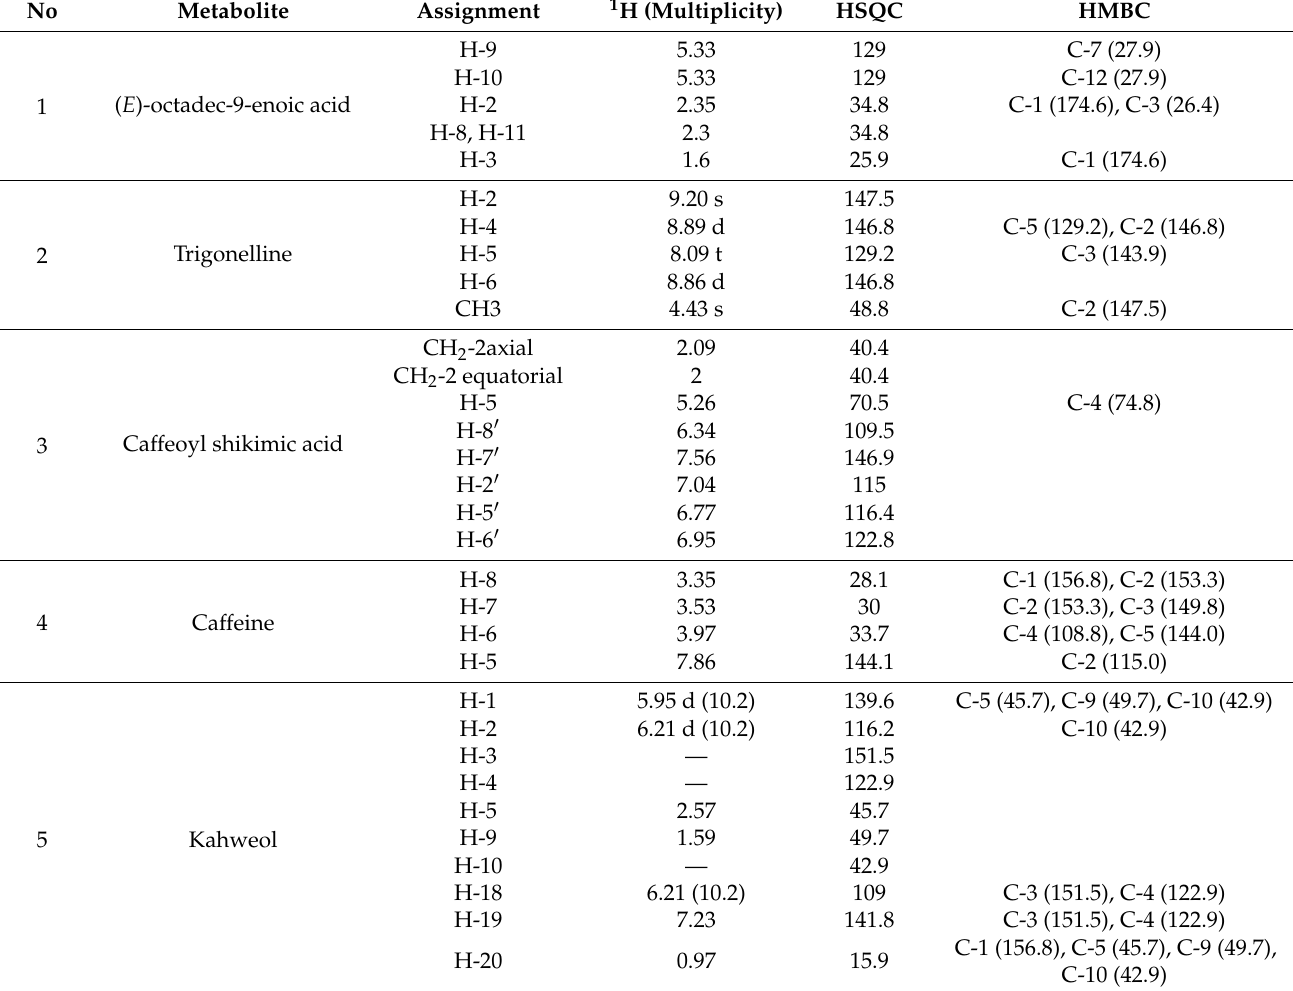
Table 1. Resonance assignments with the chemical shifts of constituents identified in 600